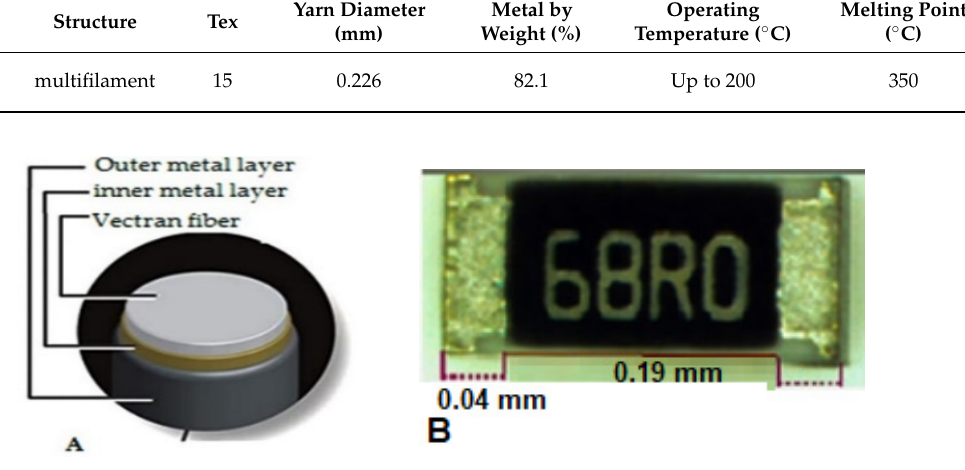
Figure 1. Silver coated Vectran (Liberator ® 40) ( A ), 68 Ω Cermet resistor SMD ( B ).